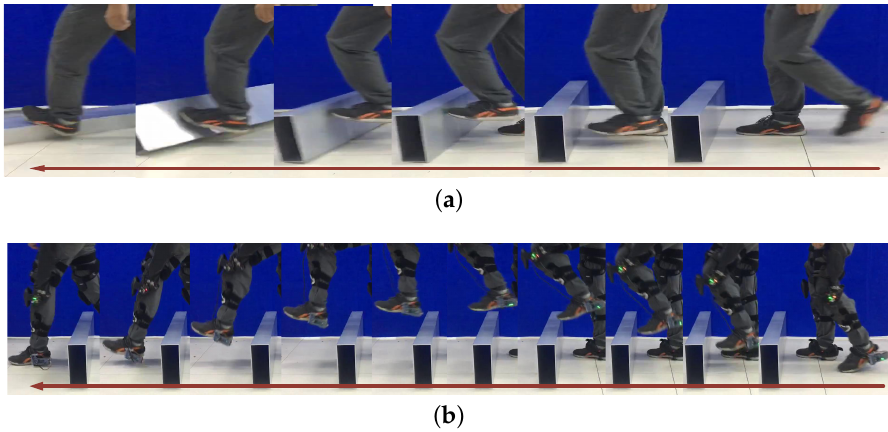
Figure 7. Experiment with stepping over a door threshold; the arrow indicates the walking direction of the pilot. ( a ) Illustration of tripping during stepping over a door threshold. ( b ) Experiment involving stepping over a door threshold with the help of the exoskeleton.